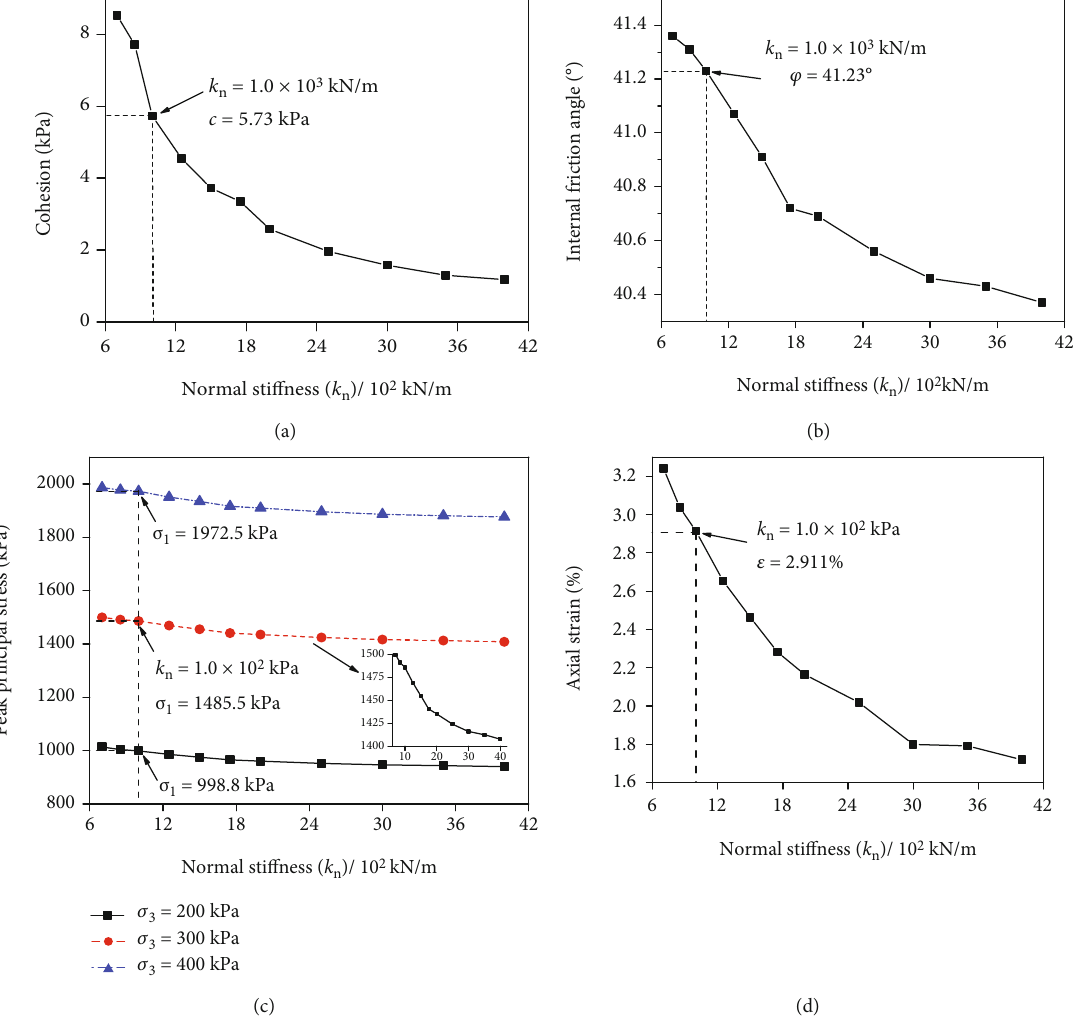
Figure 6: In fl uence of k